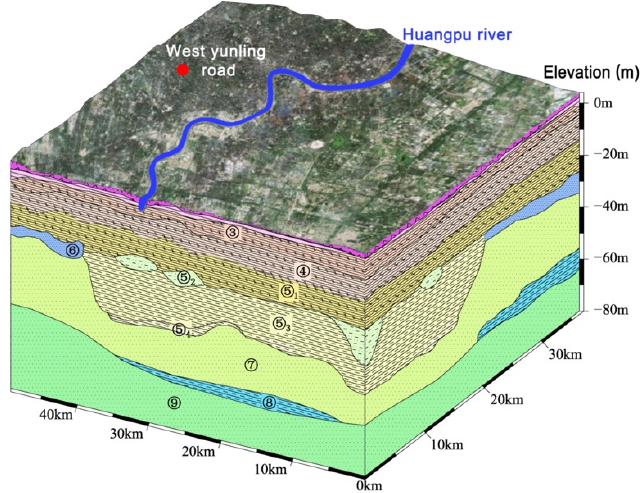
Figure 1. Typical geological structure of shallow strata in Shanghai (satellite images cited from Google Maps).